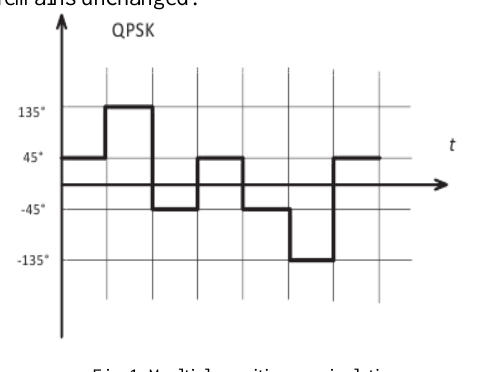
Fig. 1. Multiple position manipulation.